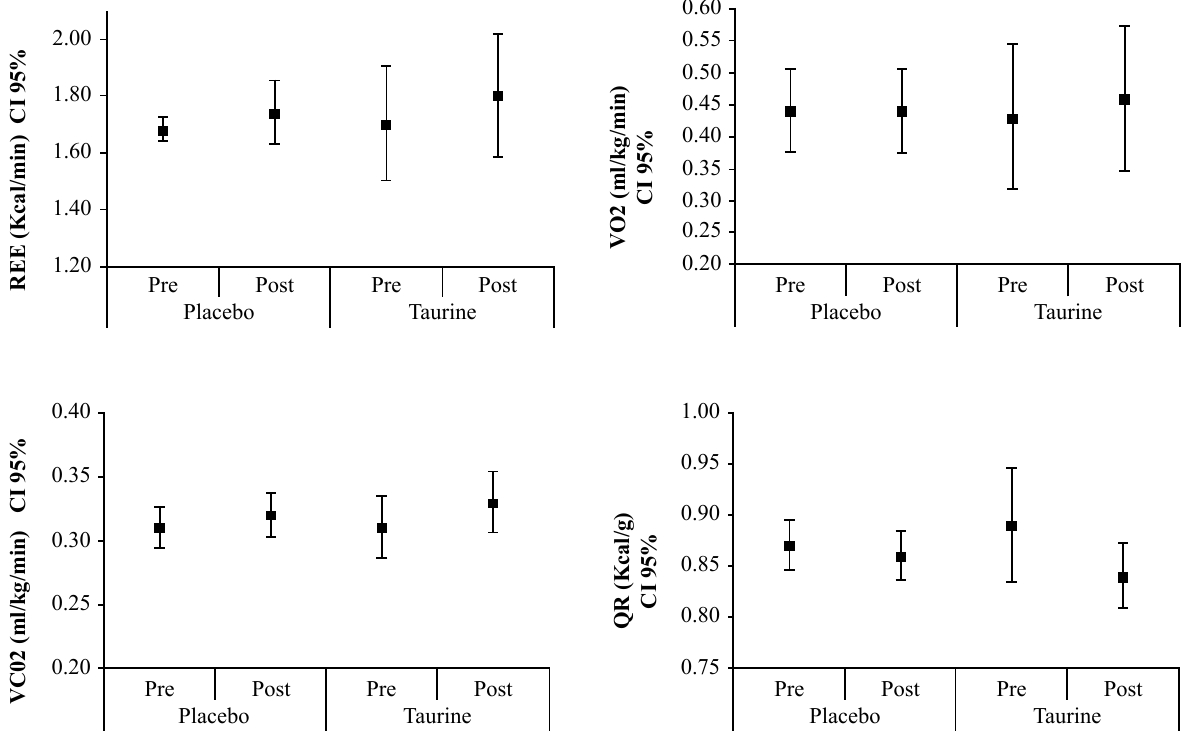
, VCO and QR before (Pre) and after (Post) 8 weeks of placebo or taurine supplementation (n = 14). 2 2